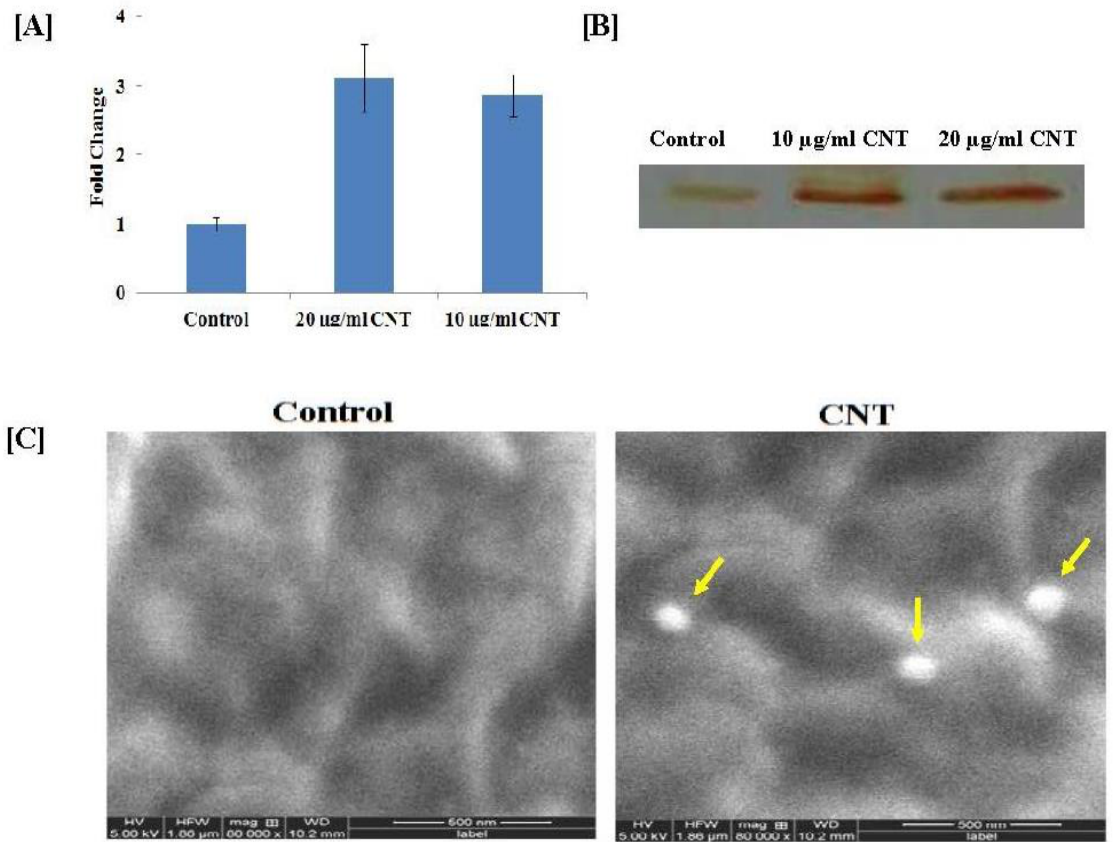
Figure 3. Peroxidase activity of CNT-treated cotton cell suspension culture after one month: ( A ) quantitative (spectrophotometer); ( B ) qualitative (in-gel activity) method; ( C ) SEM imaging of cotton cell. Pores formed by CNTs on the surface of cells grown in 20 µg/g CNTs (shown with yellow arrows) were observed clearly, which were absent in the surface of the control cell. The image was captured at a very high resolution (160,000×).